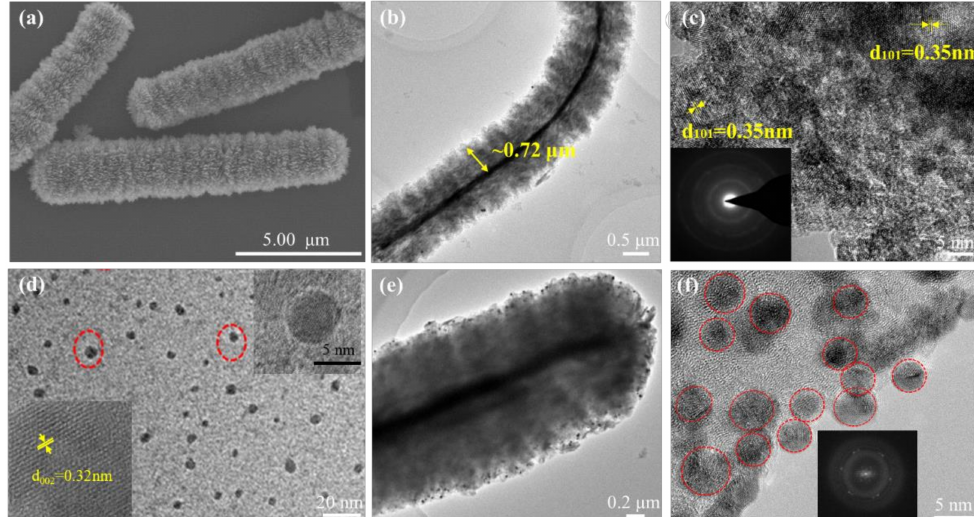
Figure 2. ( a ) SEM, ( b ) TEM and ( c ) HRTEM images of pristine TiO 2 . ( d ) TEM image of GQDs showing an average size of ∼ 5 nm. The inset shows the HRTEM lattice image. ( e ) TEM and ( f ) HRTEM images of TiO inset in image in ( f ) is the FFT pattern of